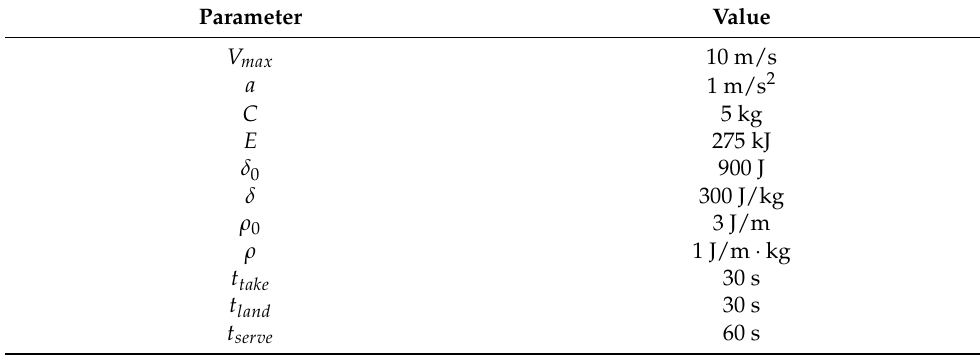
Table 3. UAV parameters.